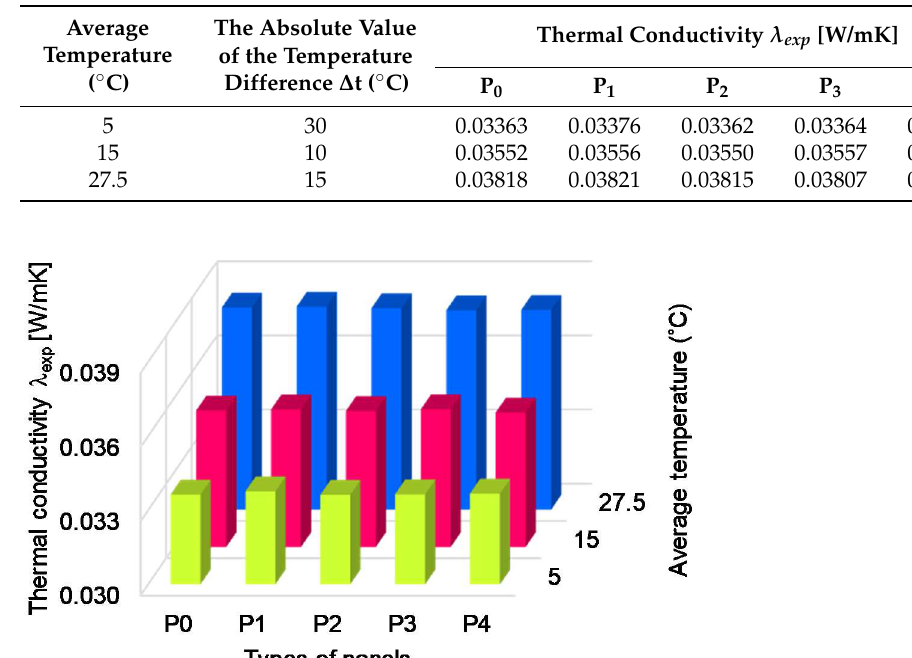
Figure 8. Variation of calculated effective thermal conductivity of the perforated panel as a function of the diameter of the channels. Legend: n —number of channels. Table 3. Thermal conductivity of panels tested at three temperature regimes.